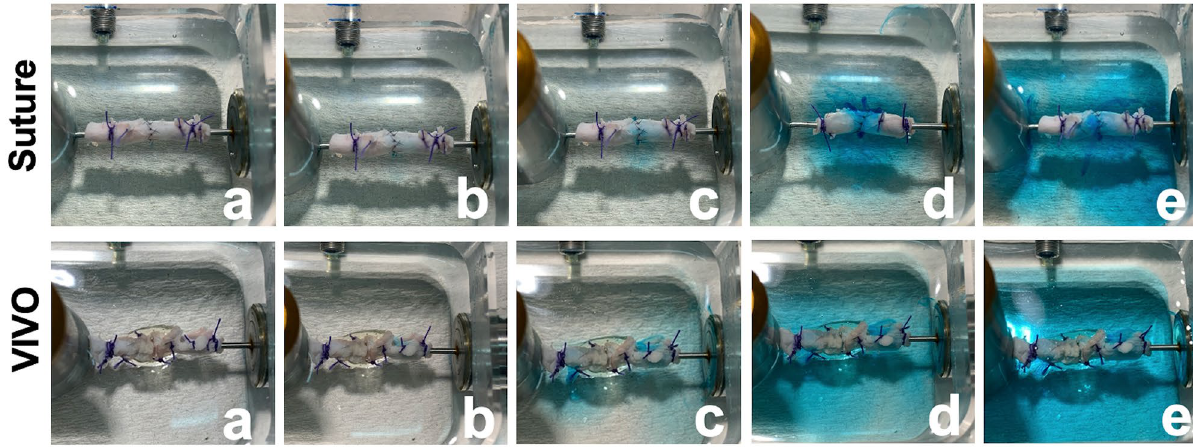
Figure 4. Image sequence of a representative burst pressure test of the Suture and VIVO group. The vessels are shown before pressure was applied ( a ). An initial leakage is visible in both anastomotic groups ( b ). Leakage > 25% of the anastomosis or leakage > 25% at of the circular vessel surface covered with VIVO ( c ). Leakage > 50% of or buffer leakage between 6 sutures or Krebs buffer leaked at > 50% of the circular vessel surface ( d ). The failure of anastomoses at 20 ml/min ( e ).